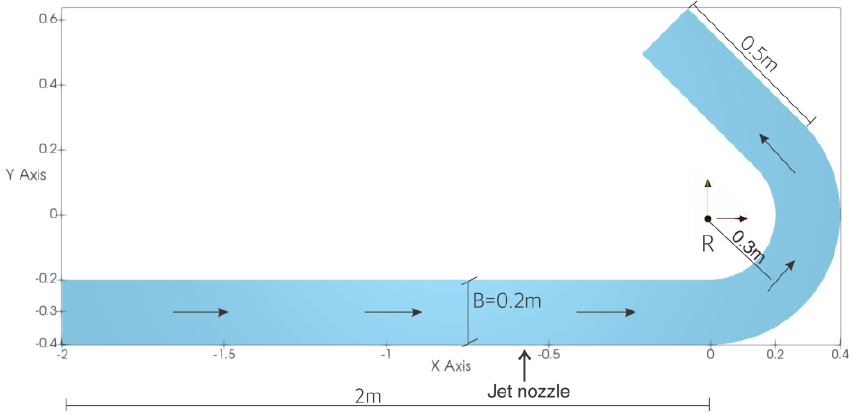
Figure 1. Flow geometry of the experiment.